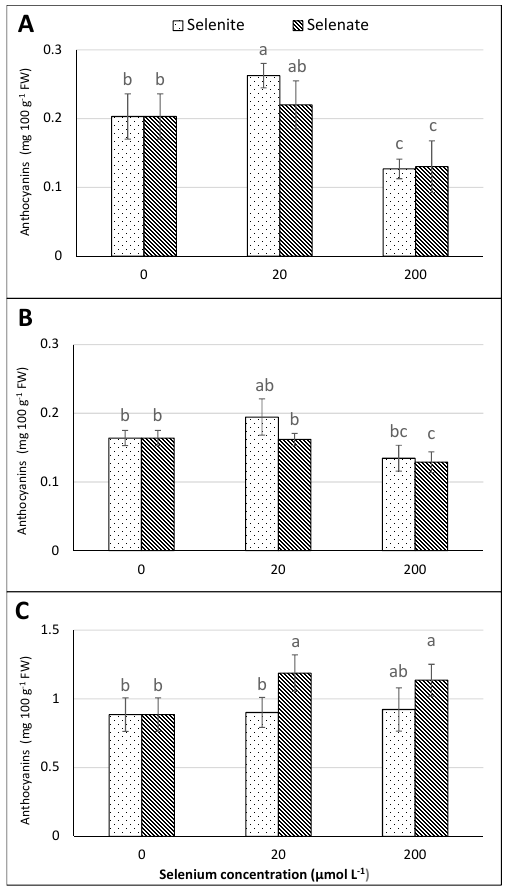
Fig. 1 Effects of selenium biofortification with selenite or selenate on l-ascorbic acid (AsA) concentrations in the sprouts of alfalfa ( A ), radish ( B ), and white mustard ( C ). Means (± SD ; N = 6) with different letters on top of the bars are significantly different ( p < 0.05) according to Tukey’s LSD test.